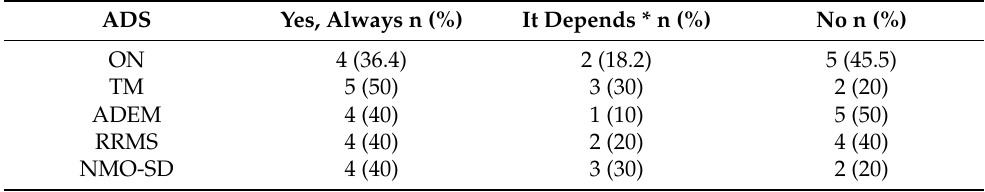
Table 2. The frequency of oral prednisone taper used per distinct acute demyelinating syndrome.